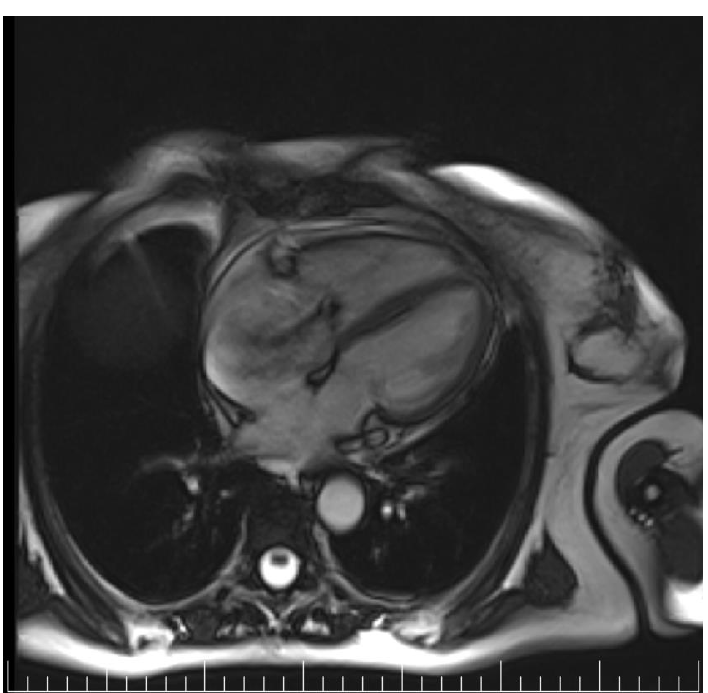
Figure 5. Cardiac MRI — severe tricuspid regurgitation.